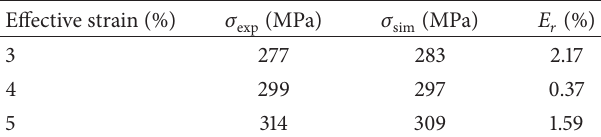
Table 2: Comparison between experimental and simulated stresses at various effective strains with a prior creep strain of 0.75%.